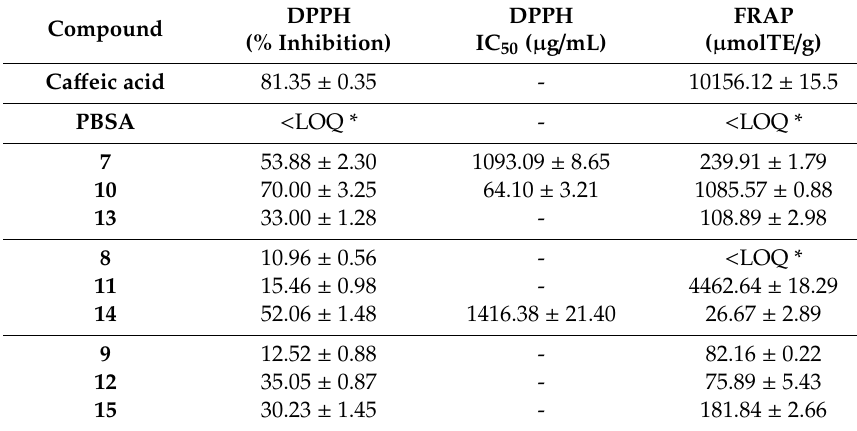
Table 2. Antioxidant activity of the compounds through DPPH and FRAP test. Each value was obtained from three different experiments (mean ± SEM). (The caffeic acid value of the DPPH test refers to a tested concentration equal to 0.0105 mg/mL).